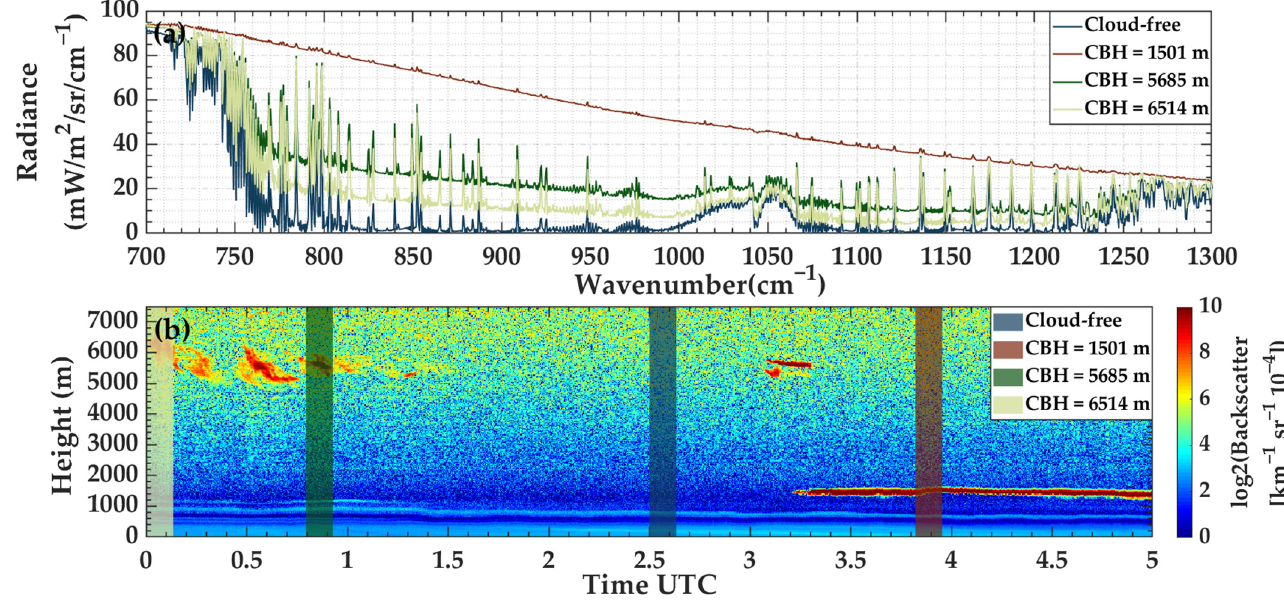
Figure 6. ( a ) Measurement of AERI under different cloud-base heights. ( b ) Backscattered echo of ceilometer from 0000 UTC to 0500 UTC on 1 January 2015. Background parts represent the corresponding time of the spectra in ( a ).